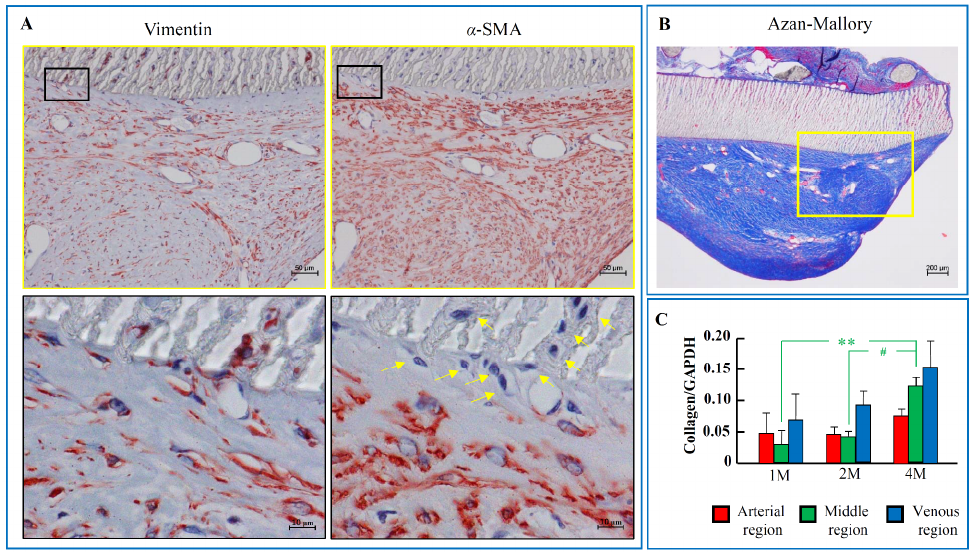
Figure 4. Representative venous immunostaining patterns of vimentin and α-SMA, as well as collagen mRNA expression levels, after PTFE graft implantation. ( A ) Immunohistologic examinations of the serial sections from the venous anastomotic regions with antibodies against vimentin and α -SMA. Yellow arrows: α - SMA negative cells ( B ) Azan–Mallory staining of the venous anastomotic region. The yellow frames in the Azan–Mallory staining indicate the vimentin and α -SMA immunostaining shown in part A. ( C ) Expression of collagen I mRNA in three different regions 1, 2, and 4 months after PTFE graft implantation. Each bar represents the mean ± S.E.M. of six grafts. ** p < 0.01 vs 1 M; # p < 0.05 vs 2 M.